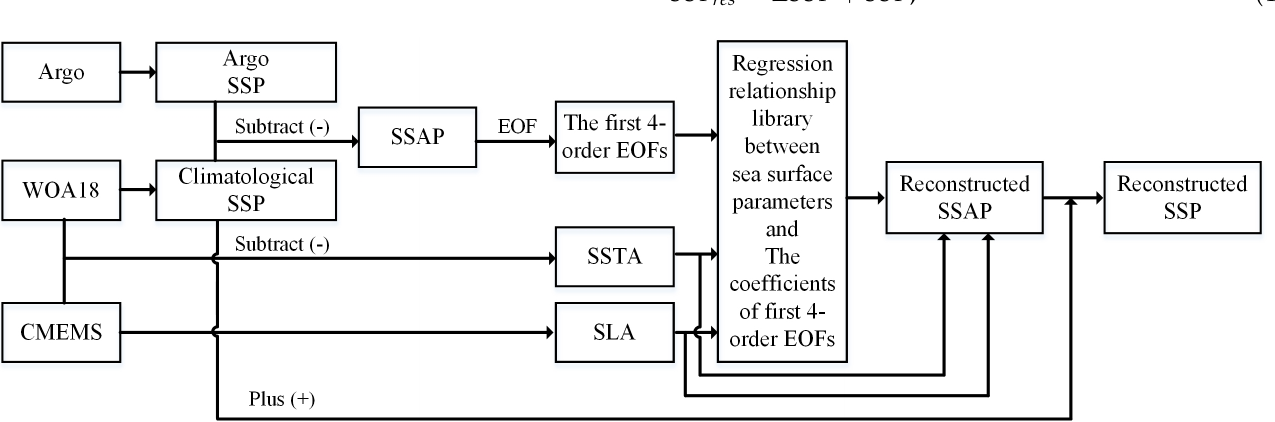
Figure 2. The process flow diagram for the SSP reconstruction. SSAP, sound speed anomaly profile; SLA, sea level anomaly; SSTA, sea surface temperature